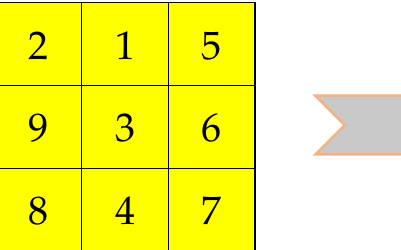
Table 4. FLIR Lepton® specification.